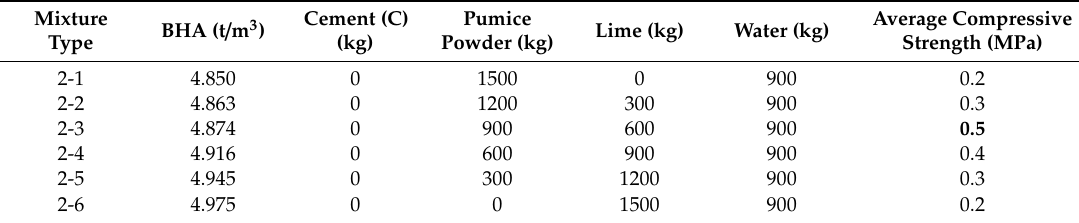
Table 23. Type-2 mixture quantity, unit volume weight and compressive strength test results.